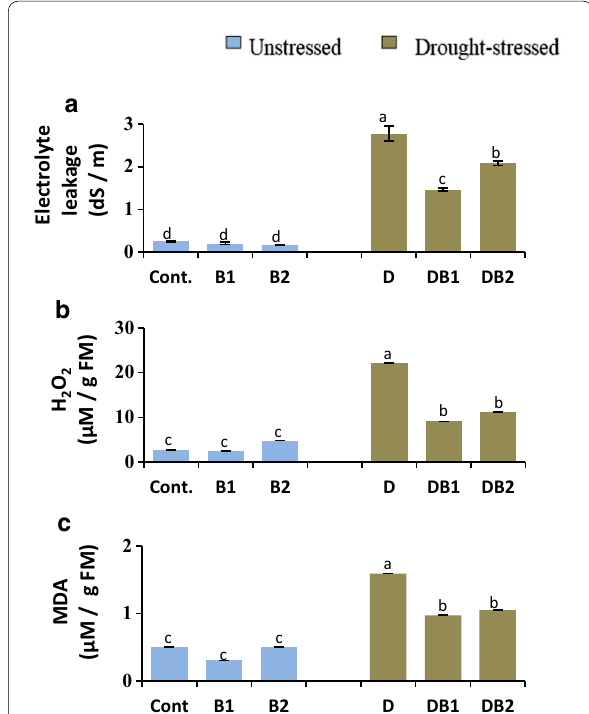
Fig. 4 Effect of bacterial inoculation with Azospirillum brasilense NO40 (B 1 ) and Stenotrophomonas maltophilia B11 (B 2 ) on a electrolytes leakage; b H 2 O 2 content; and c malondialdehyde (MDA) content of the leaves of 15-day-old Triticum aestivum L. seedlings (cv.G9) grown in sandy soil, under unstressed and drought-stressed conditions (7 days of water withholding). Error bars represent the standard deviation between 3 replica. Treatments with identical letters are not significant at P 0.01. Cont. unstressed-uninoculated ≤ ≡ treatment; D drought-stressed-uninoculated treatment; ≡ B 1 and B 2 unstressed-inoculated treatments; DB 1 and ≡ DB 2 drought-stressed- inoculated treatments =